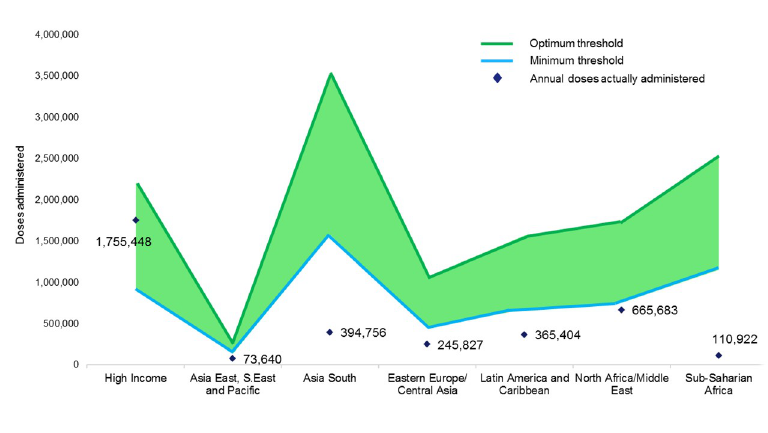
Fig 1. IgG anti-Rh(D) doses actually administered annually, as compared with minimum and optimum thresholds for immunoprophylaxis. The GBD Super Regions are indicated along the x-axis and the annual number of doses of IgG anti-Rh(D) are indicated along the y-axis. The annual numbers of IgG anti-Rh(D) doses actually administered in each GBD Super Region are indicated by filled-in black diamonds. The minimum threshold number of annual IgG anti-Rh(D) doses (i.e., the number required to provide post-partum immunoprophylaxis only) is indicated by the blue line; the optimum threshold number of annual IgG anti-Rh(D) doses (i.e., the number required to provide both antenatal and post-partum immunoprophylaxis only) is indicated by the green line. The “acceptability area” is indicated in light